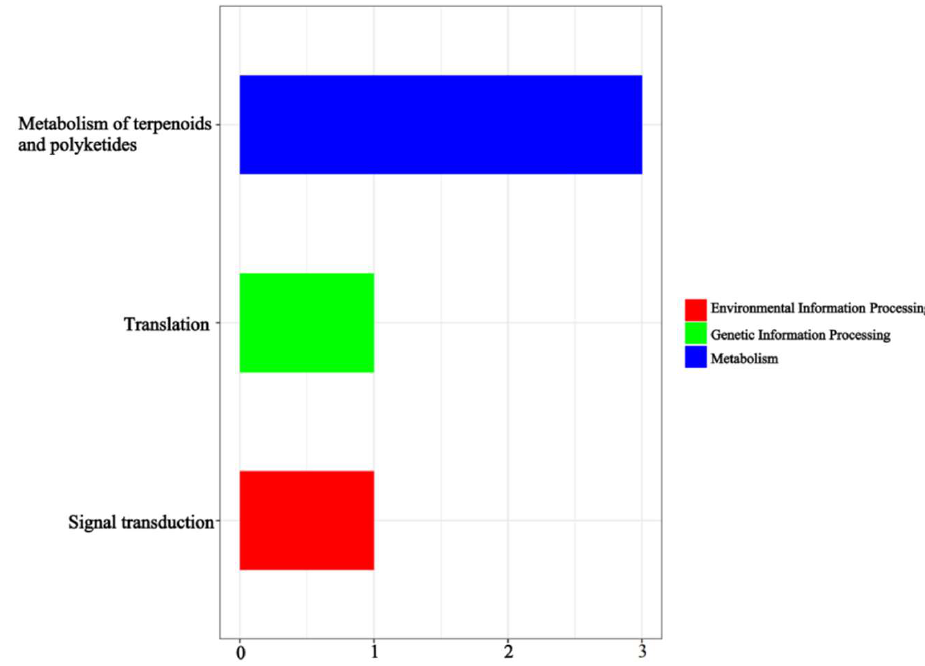
Figure 7. The enriched KEGG terms.